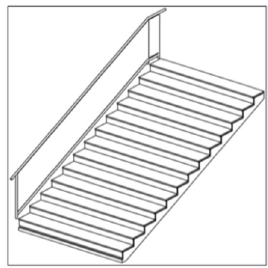
Figure 10. Pictogram-based “Stairs”. Figure 11. Axonometric-based “Stairs”.